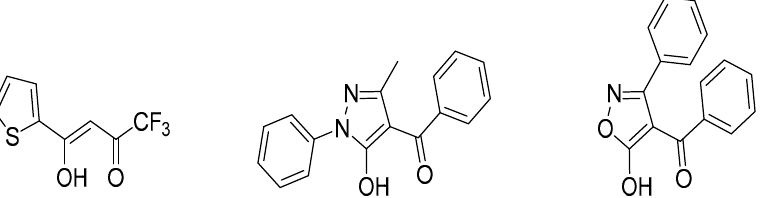
Figure 3. Structural formulas of the chelating extractants (HTTA, HP, and HPBI, respectively).